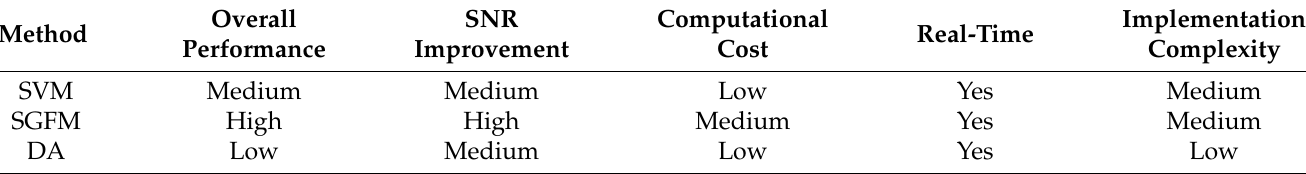
Table 4. Summary of the EOG signal processing methods.